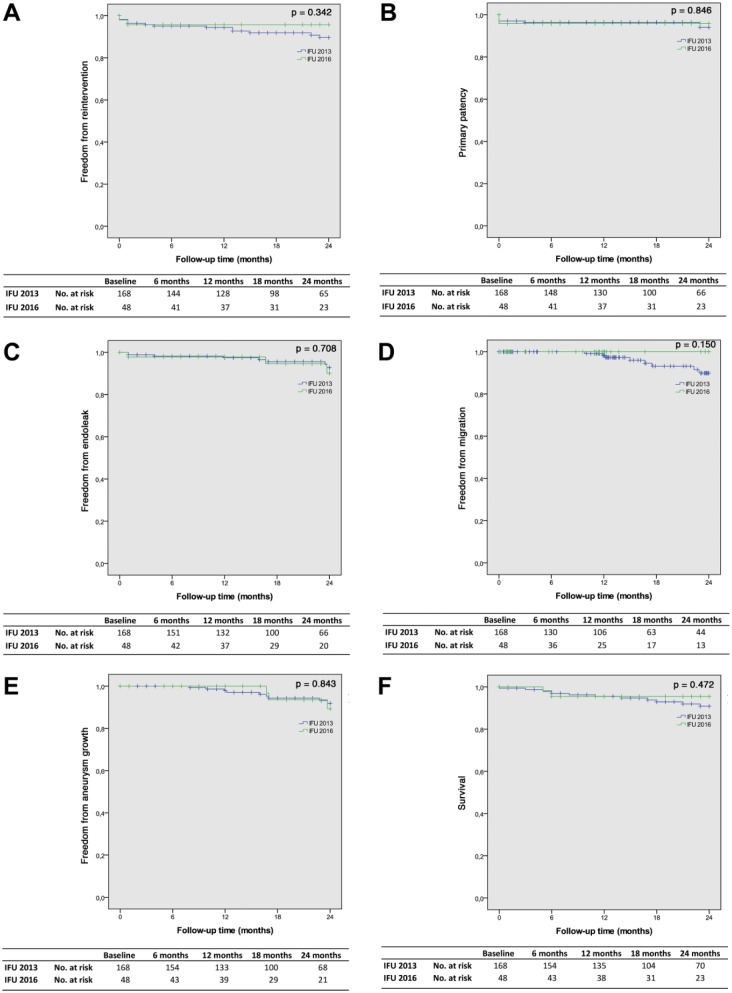
Kaplan-Meier analyses of (A) freedom from reintervention, (B) primary patency, (C) freedom from any endoleak, (D) freedom from migration, (E) freedom from aneurysm growth, and (F) overall survival. The standard error did not exceed 10% at any time point in all curves.